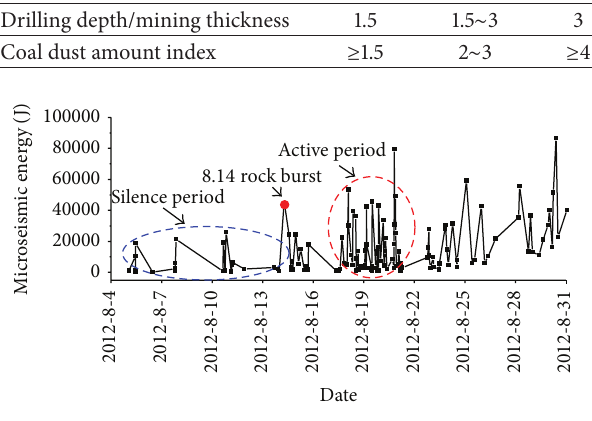
Figure 2: Microseismic events statistical data curve.